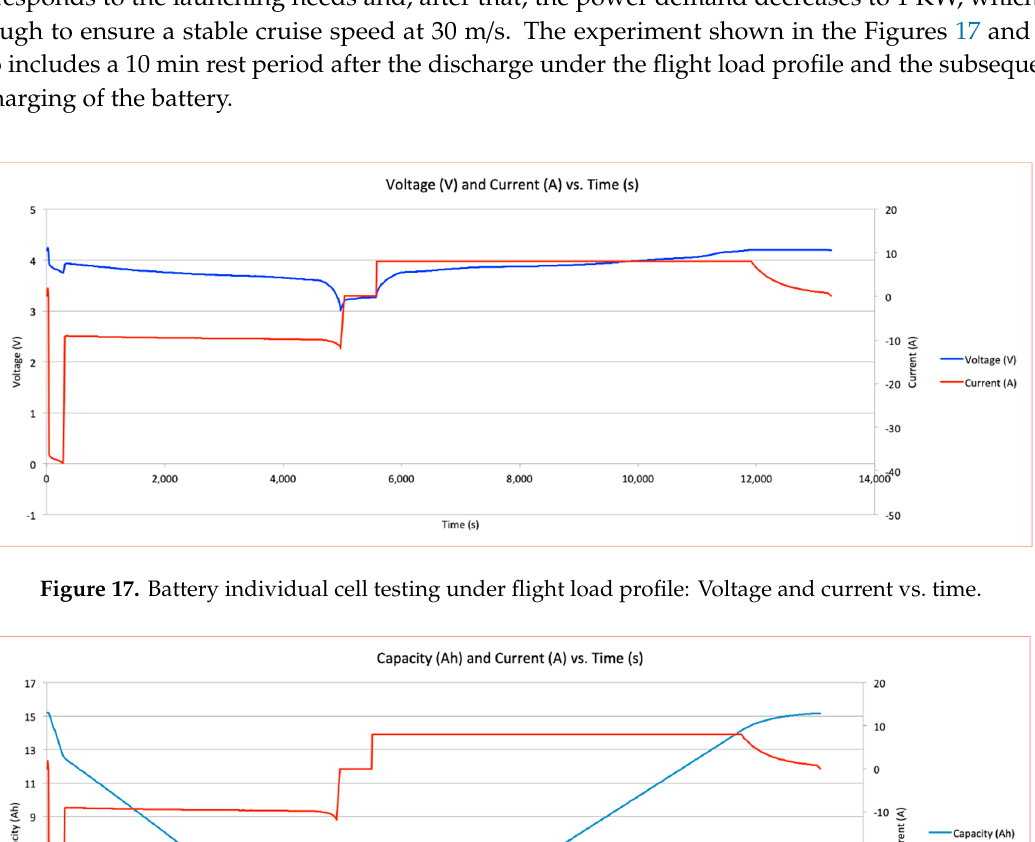
Figure 16. Battery individual cell testing: Capacity and current vs. time.